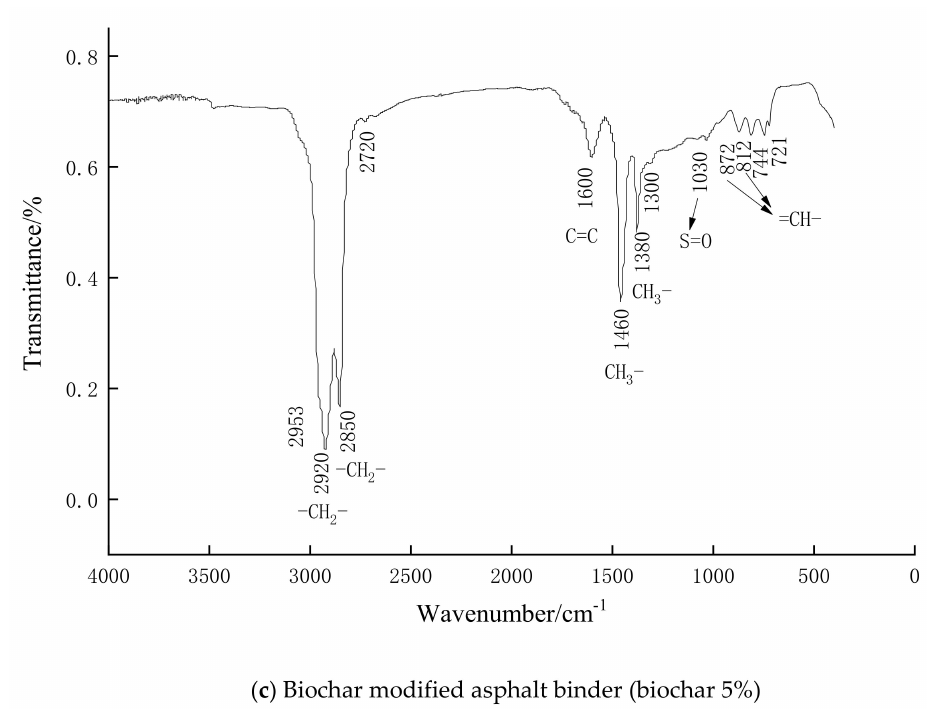
Figure 11. FTIR spectra of base and modified binders with 5%